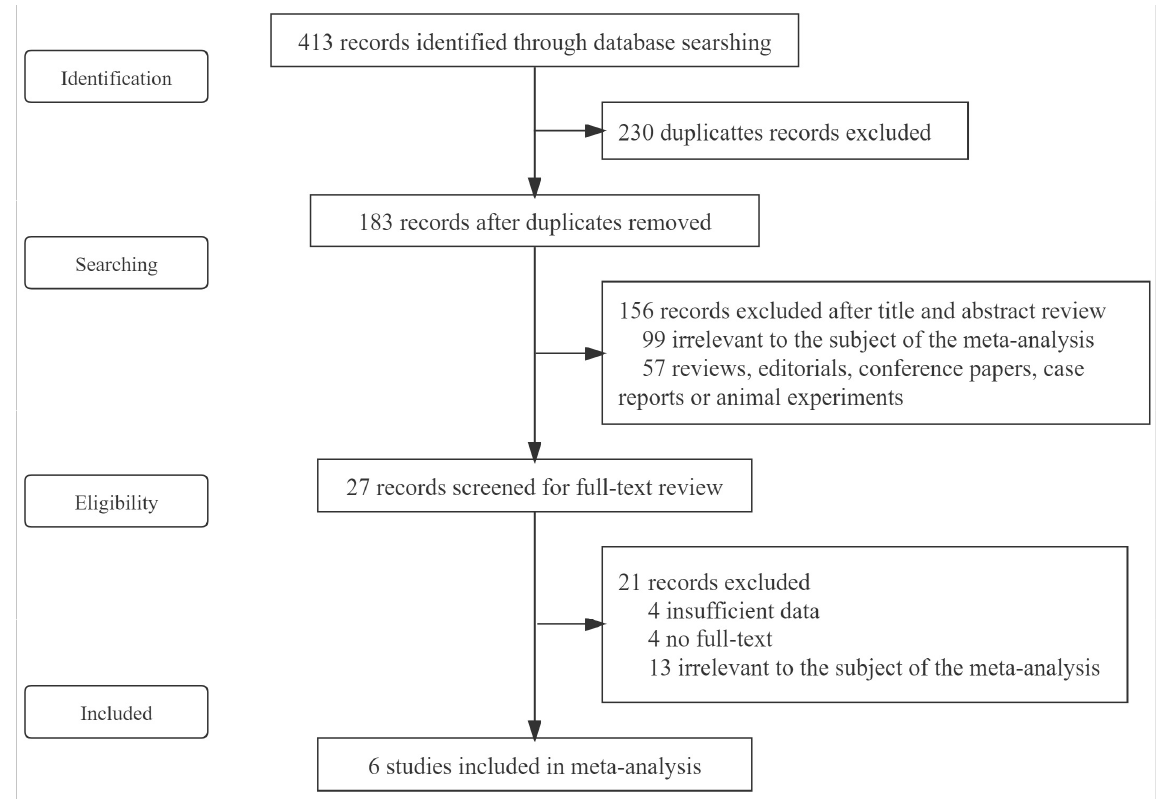
Figure 1. Flowchart of the study selection.